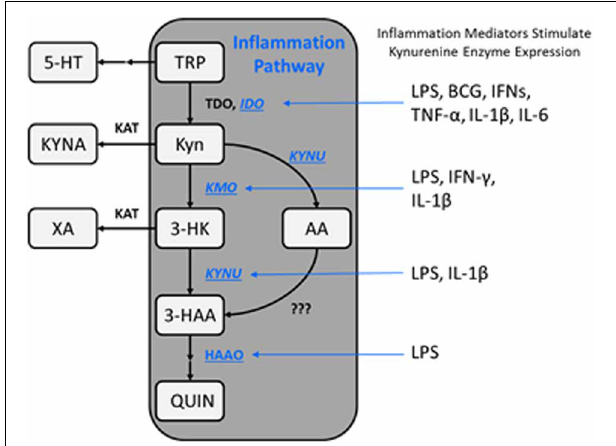
FIGURE 1 | Schematic representation of the kynurenine metabolic pathway. The kynurenine pathway is commonly segregated into two distinct branches that are regulated by KATs and KMO, as well as the availability of l-kynurenine within the brain. Additionally, kynurenine metabolism is regulated by a variety of proinflammatory mediators which impact enzyme expression levels, thereby altering substrate availability and metabolite formation favoring the KMO branch of the pathway under immune-related pathological conditions. TRP, tryptophan; 5-HT, serotonin; Kyn, kynurenine; KYNA, kynurenine acid; 3-HK, 3-hydroxykynurenine; AA, anthranilic acid; XA, xanthurenic acid; 3-HAA, 3-hydroxyanthranilic acid; QUIN, quinolinic acid; IDO, indoleamine-2,3-dioxygenase; KAT, kynurenine aminotransferase; KMO, kynurenine 3- monooxygenase; KYNU, kynureninase; HAAO, 3-hydroxyanthranilic acid oxidase; LPS, lipopolysaccharide; BCG, bacillus Calmette-Guerin; IFNs, interferons; TNF, tumor necrosis factor; IL,